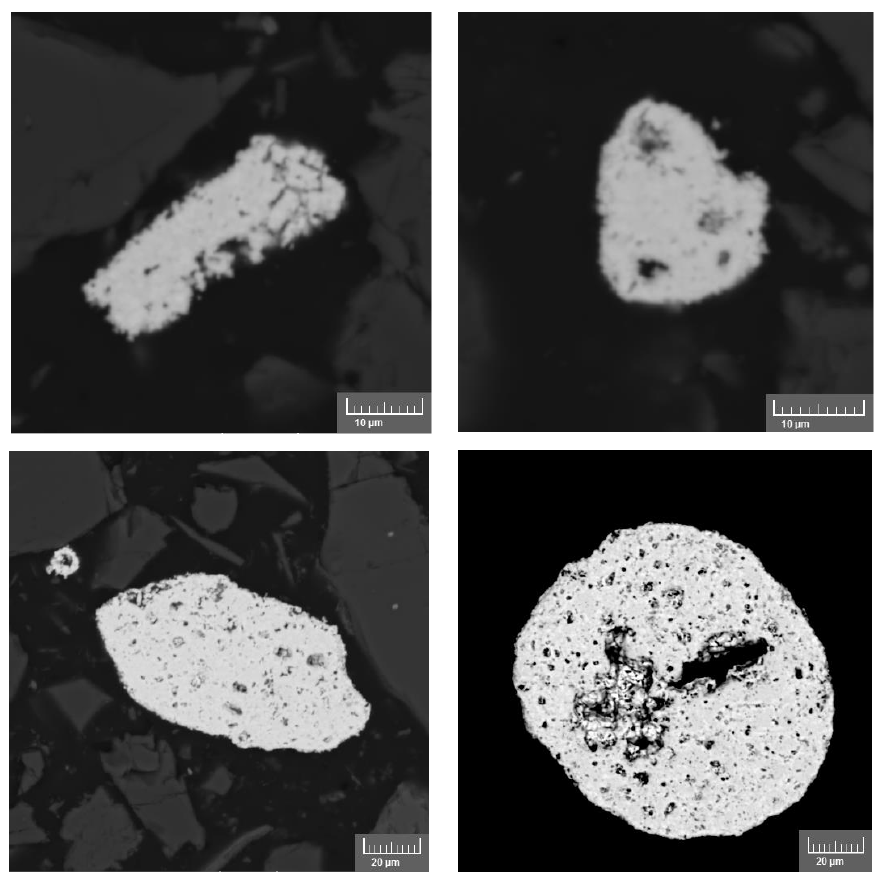
Figure 4. Typical uraninite occurrences observed via BSE in the BHP tailings samples. Based on the acid-base accounting results, BHP tailings were classified as acid gen- erating, since the PN/PA ratios obtained using the Sobek and Lawrence and Wang meth- ods both showed values well below 1. Additionally, the neutralization potential of the carbonates ranged between 5.66 and 7.08. This implies that the tailings have good buffer- ing capacities resulting from the strong reactivity of carbonates in acidic conditions. 3.2. Leachate Analysis As mentioned previously, the leachate pH, oxidoreduction potential (ORP) and elec- trical conductivity (EC), as well as the major and minor element concentrations were mon- itored once a week. 3.2.1. pH, ORP and EC pH measurements remained around circumneutral values (ranging from 6.5 to 7.5) during the entire study for all tested scenarios (Figure 5). pH range measured indicate that the entire study took place during the initial phase of acid mine drainage, when the neu- tralizing minerals (carbonate-, silicate- and hydroxide-bearing minerals) are not yet fully depleted and are in sufficient quantity to buffer the acidity produced by the oxidation of sulfur. This pH behavior is consistent with other column studies performed on acid-gen- erating tailings. Indeed, multiple months and sometimes years can be necessary before a decrease in pH is observed for the leachate [13,41].